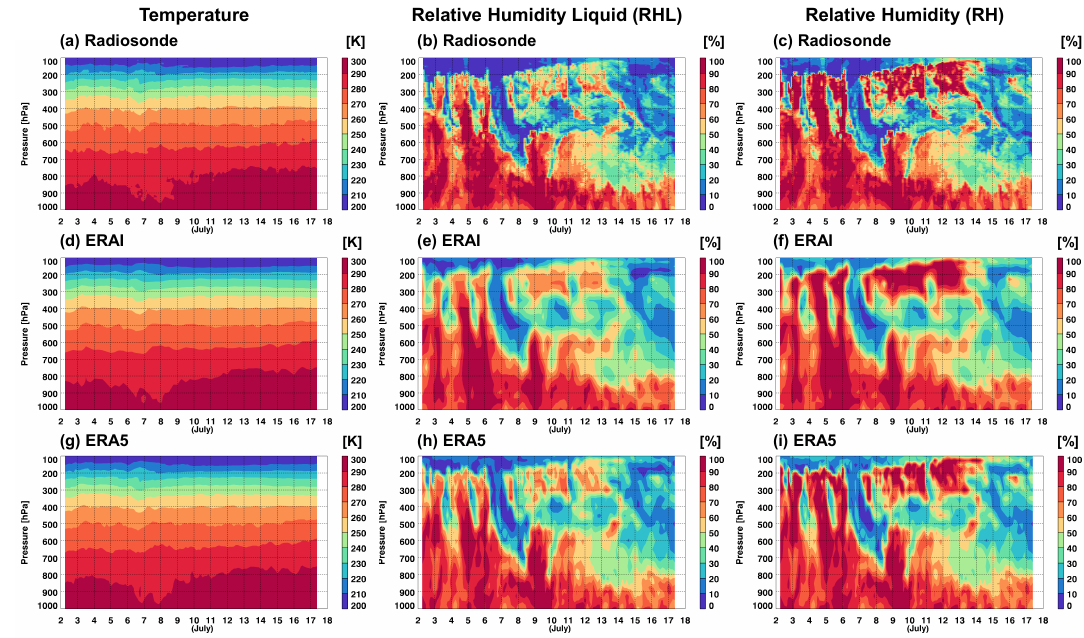
Figure 4. Time series of profiles of temperature (left), relative humidity with respect to liquid (middle), and relative humidity (right) based on ( a – c ) radiosonde, ( d – f ) ERAI, and ( g – i ) ECMWF Reanalysis 5 (ERA5) datasets at the Boseong station in July 2018.